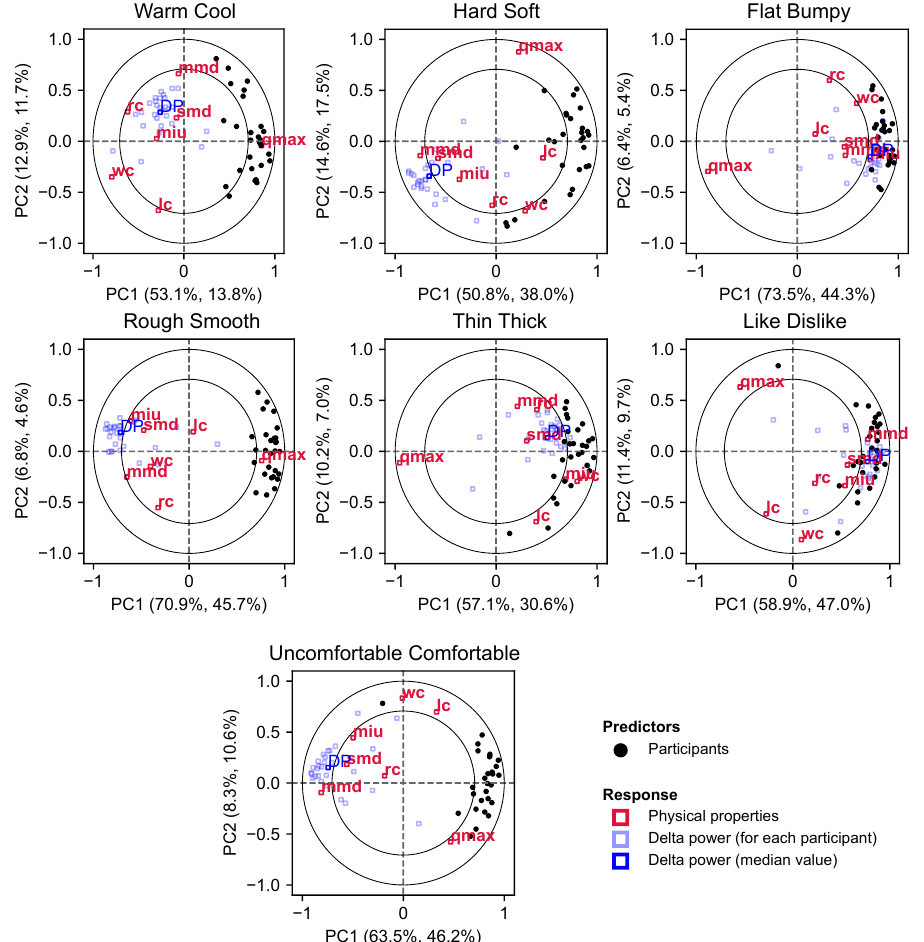
Figure 9. Principal component regression—correlation loadings plots . Physical properties and delta power were regressed onto the principal components of the sensory dataset. The regression coefficients (regression loadings) are plotted in red. The percentages shown on the left indicate the explained variance in the component. On the right, the mean R 2 values for all the response variables in the component are shown. Delta power was regressed without averaging and the medium value (blue) is highlighted. Roughly, values inside the inner ellipse are not significant ( p -value >